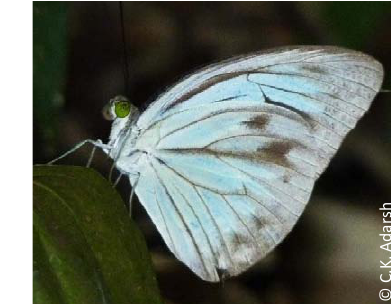
Image 21. Pareronia hippie Common